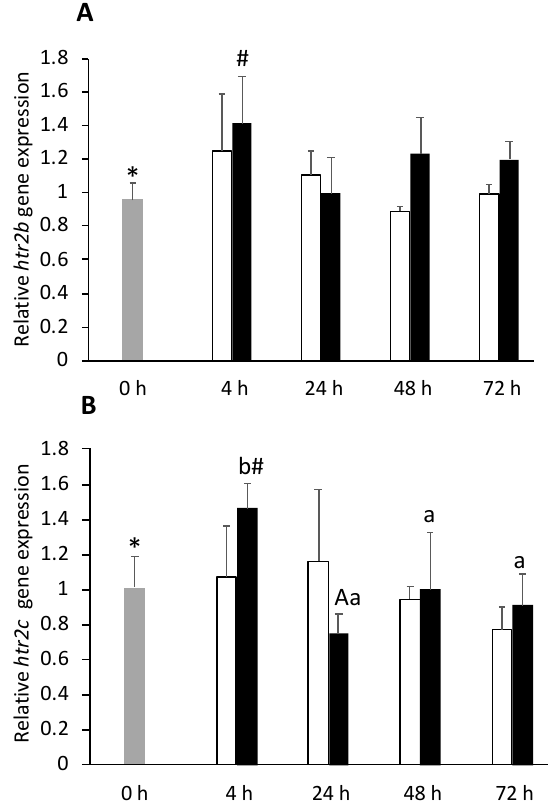
Figure 1. Telencephalic expression of serotonin receptors 2B ( htr2b , A ) and 2C ( htr2c , B ) in undisturbed European seabass (0 h, ) or i.p.-injected with a sham solution (CTRL, □ ) or Freund’s